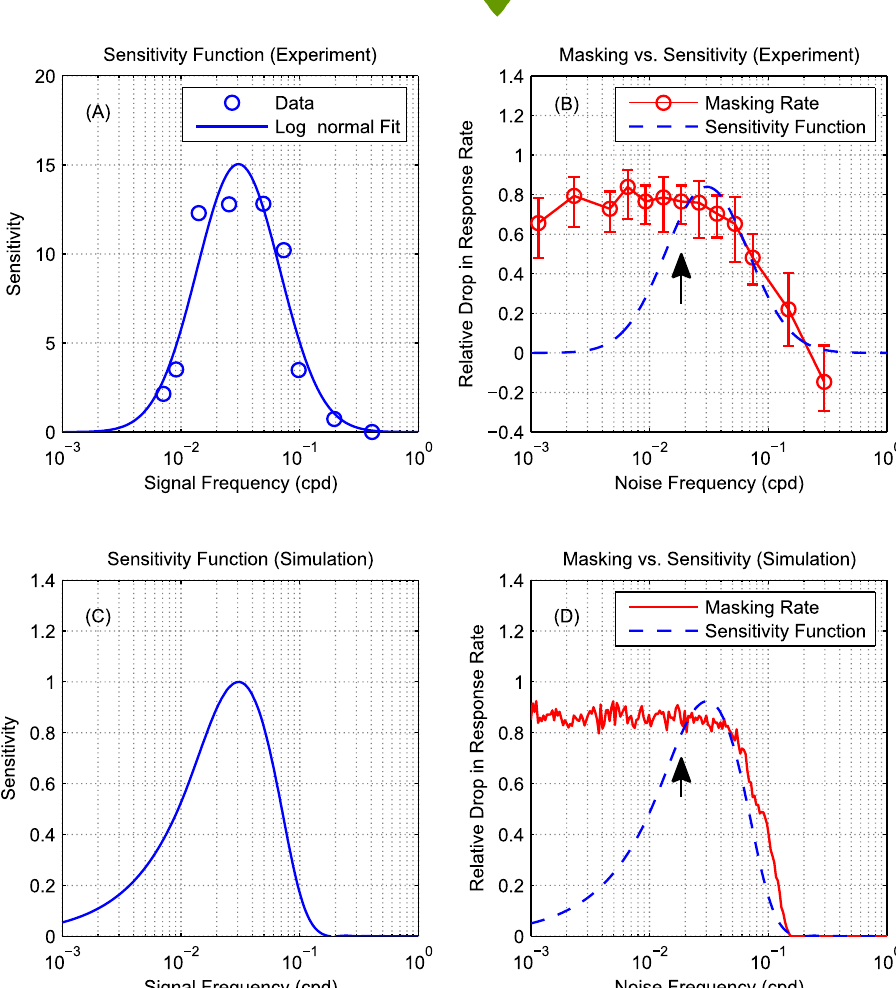
Figure 5. For mantis motion detection, masking function does not reflect sensitivity. ( A ) The spatial sensitivity of mantis motion detectors at 8 Hz, measured using the same experimental paradigm, showing bandpass sensitivity in the range 0.01 to 0.1 cpd (reproduction of Fig. 3a in ref. 31). ( B ) Measurements showing the effect of noise on the detection of a moving grating in the praying mantis. Circles are masking rate M defined as M = ( R 0 − R )/ R 0 where R is the response rate (proportion of trials in which mantids responded optomotorally in the same direction as the signal grating) and R 0 is the baseline (no-noise) response rate. Error bars are 95% confidence intervals calculated using simple binomial statistics. Signal frequency (0.0185 cpd) is marked on the plot with an arrow. The response rate measured at 0.03 cpd was slightly below baseline and so the calculated masking rate was negative. ( C ) Normalized sensitivity function of a motion energy model tuned to 0.03 cpd 19 . ( D ) Simulated masking function (red) with the simulated sensitivity function reproduced for comparison (blue dotted line, scaled to same peak). Masking and sensitivity functions in the mantis are qualitatively different: noise below the lower end of the sensitivity function (~0.01 cpd) continues to mask the